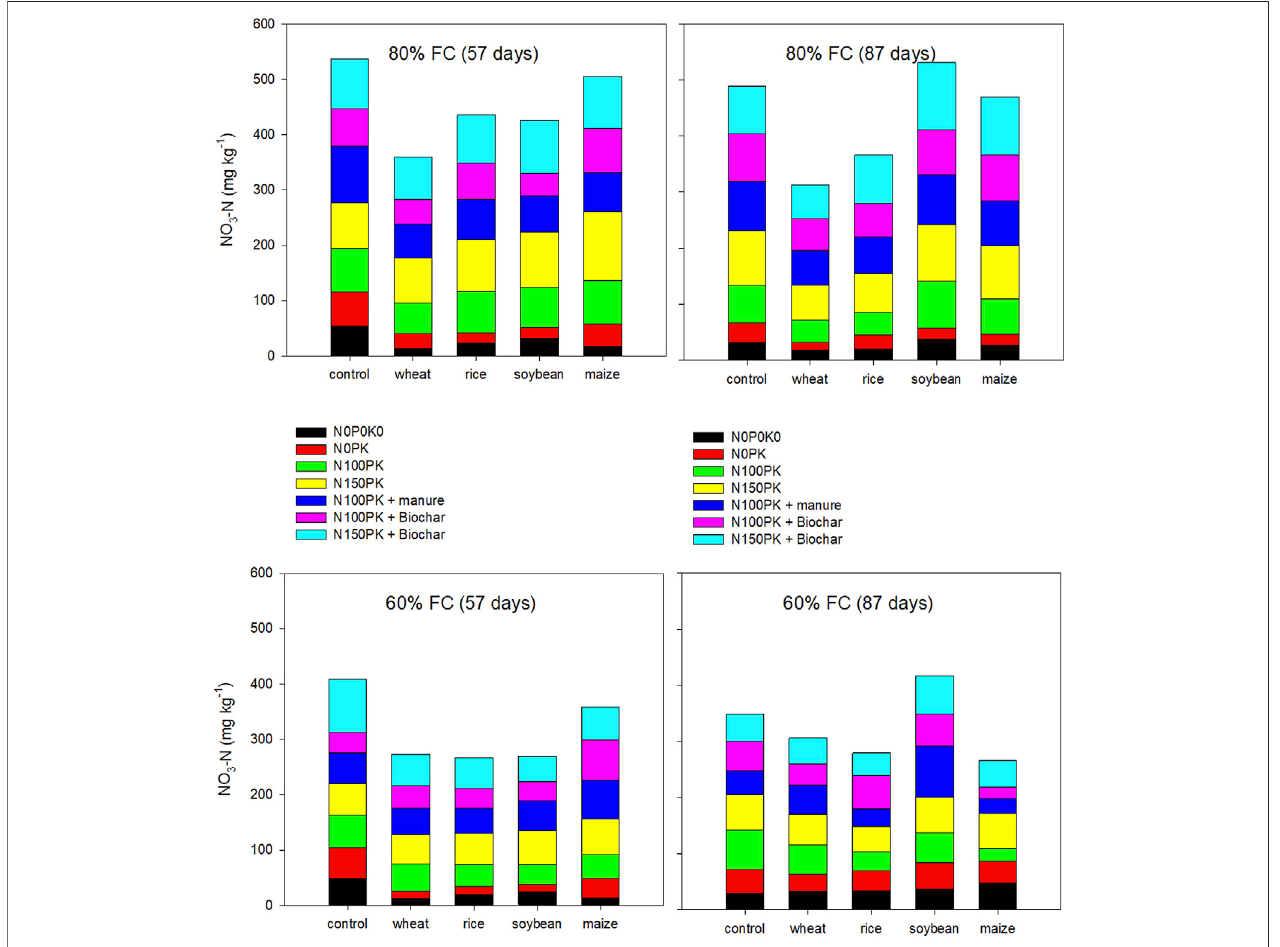
FIGURE 1 | Soil NO 3 -N (mg kg − 1 soil) as in fl uenced by residues and nutrients at 57 and 87 days of incubation under 80 and 60% FC soil moisture. Details of statistical analysis are provided in Tables 2 , 3 .